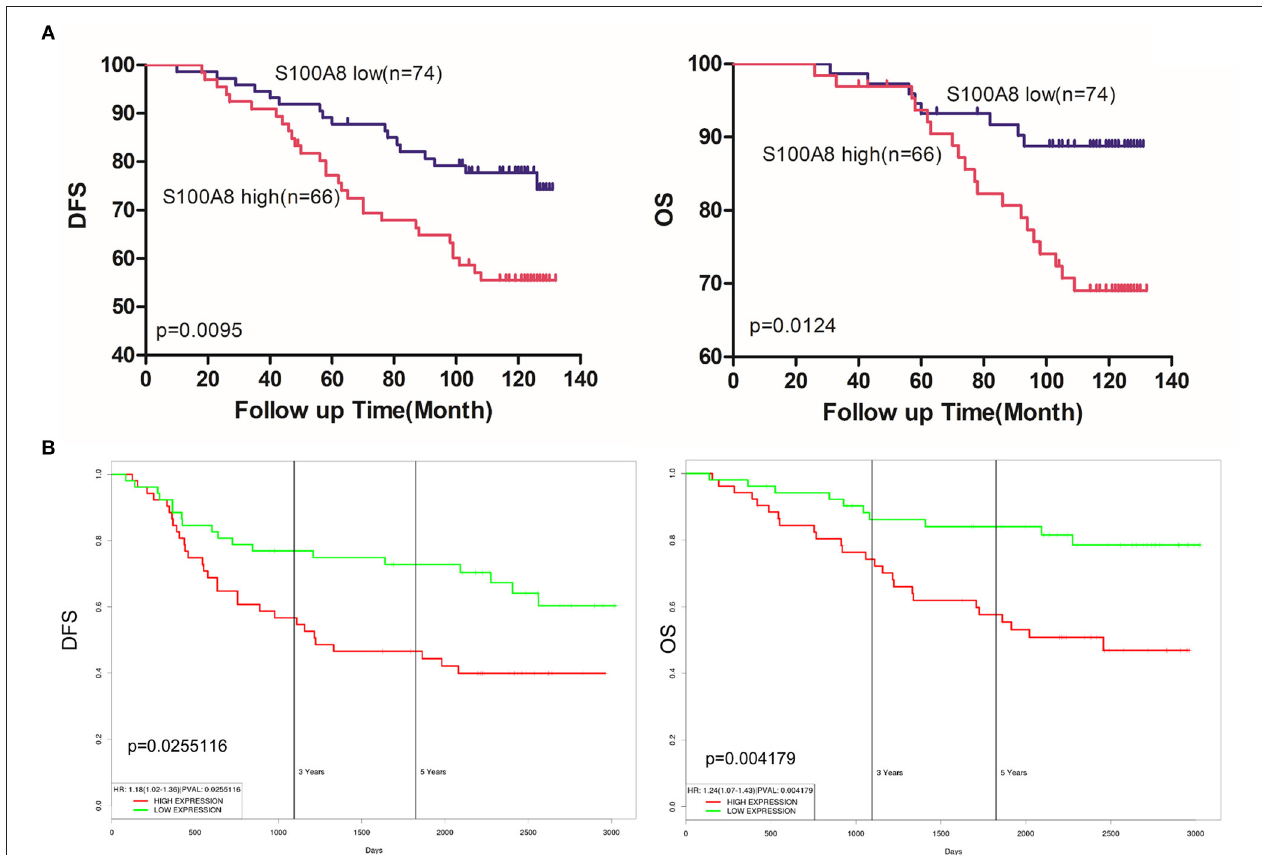
FIGURE 6 | S100A8 expression predicts survival in breast cancer. (A) Kaplan-Meier analysis of the correlations between S100A8 expression and DFS and OS in breast cancer patients. (B) Kaplan-Meier plots of the online breast cancer database (Prognostic Database PROGgeneV2) were used to assess associations between S100A8 gene expression and patient survival in breast